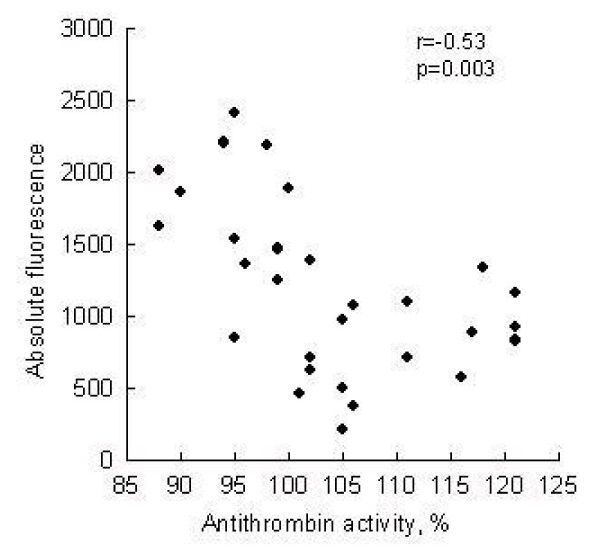
Plot of plasma antithrombin activity and platelet adhesion expressed as absolute fluorescence under low shear stress (n = 29, shear rate 13 s-1, 15 sec of perfusion). Spearman's rank correlation coefficient was -0.53, p < 0.05.